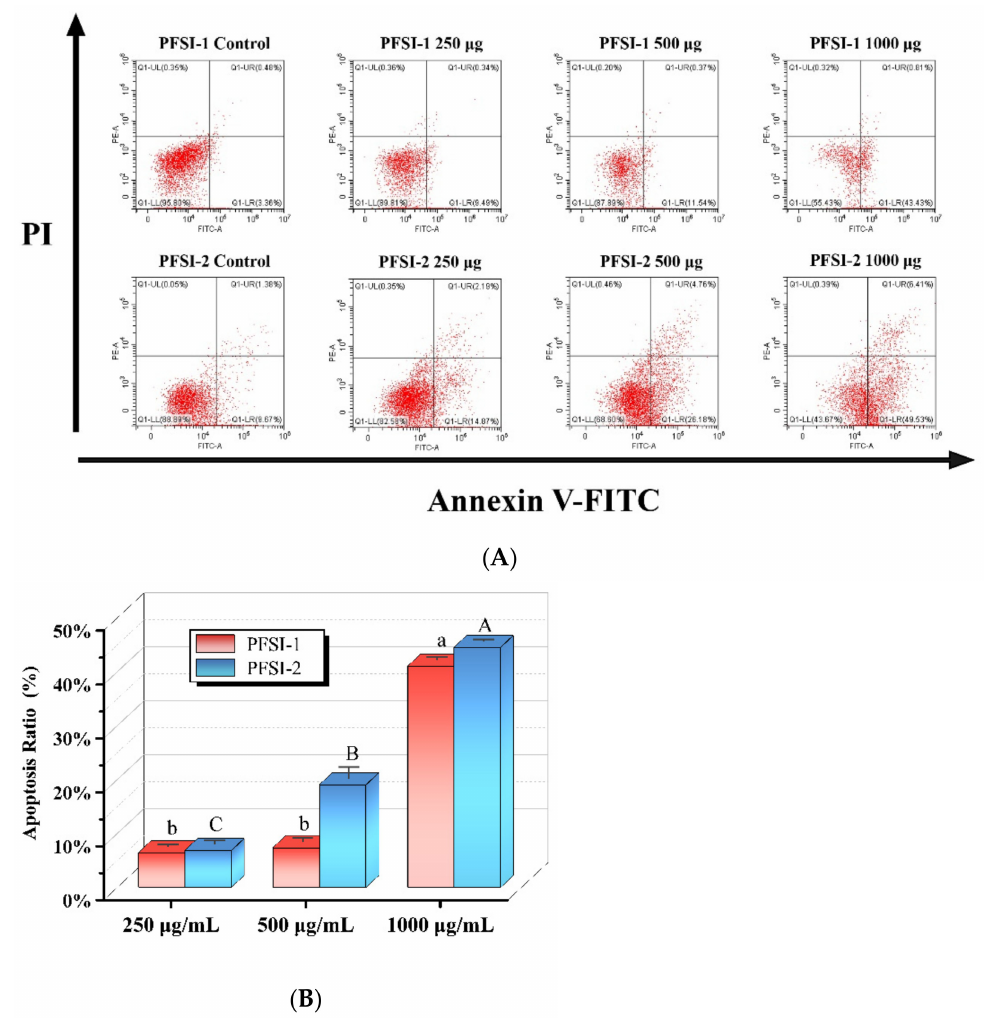
Figure 12. Effect of PFSI-1 and PFSI-2 on apoptosis ratio of SMMC 7721 cells. (Note: ( A ) represents the summary graph of PFSI-1 and PFSI-2 at apoptotic levels in SMMC 7721 cells as detected by flow cytometry; ( B ) represents histograms of the levels of apoptosis in SMMC 7721 cells at different concentrations of PFSI-1 and PFSI-2; the same small (capital) letters indicate no significant difference between groups, and different small (capital) letters indicate a significant difference between groups, p <